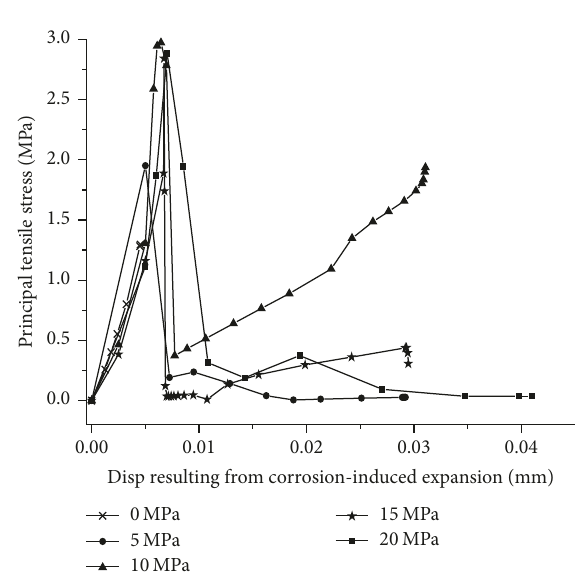
Figure 15: Load-principal tensile stress time-history curve for ele- ment